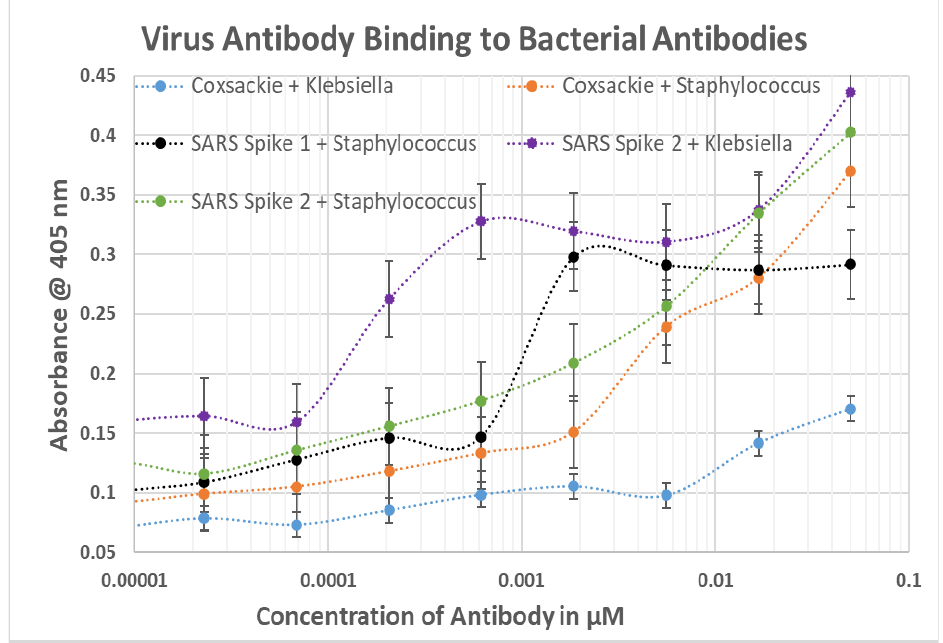
Figure 13 . Results of DA-ELISA experiments testing for various virus antibodies binding to various bacterial antibodies. Because both the virus and bacterial antibodies are polyclonal, multiple sets of complementary interactions are possible and the resulting curves are often not the simple S-shaped ones that are normally associated with binding curves. SARS = SARS-CoV-2.